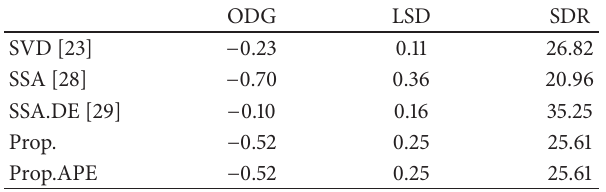
Table 4: ODGs, LSDs, and SDRs: comparison of the conventional scheme with the differential evolution (SSA.DE), proposed scheme without the automatic parameter estimation (Prop.), and proposed one with the automatic parameter estimation